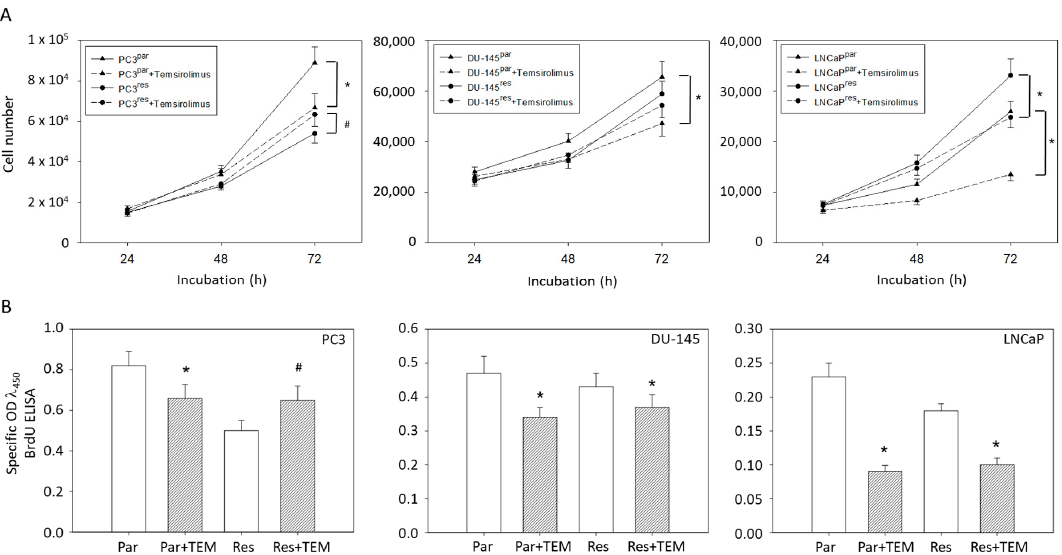
Figure 1. ( A ) Cell growth and ( B ) proliferation of PC3 par / PC3 res , DU-145 par / DU-145 res and LNCaP par / LNCaP res with and without (re)incubation with low-dosed (10 nM) temsirolimus. Measurements were done in triplicate and repeated five times. One representative experiment is shown. OD = optical density. * indicates significant down-regulation following temsirolimus (re)incubation, # indicates significant up-regulation following temsirolimus (re)incubation.